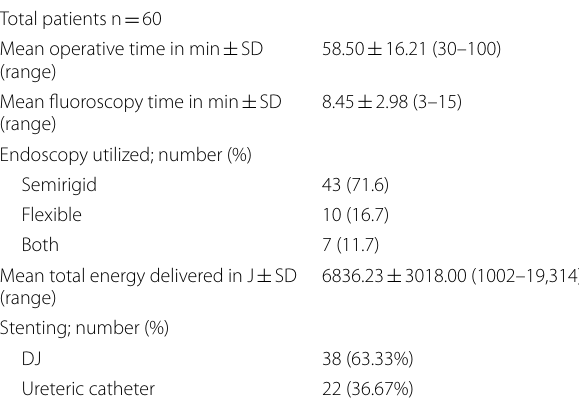
Table 2 Intraoperative parameters